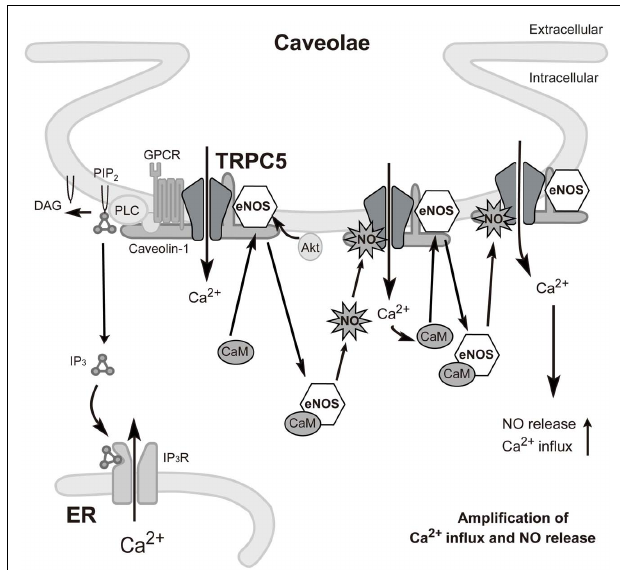
FIGURE 3 | Proposed model forTRPC5-mediated feedback cycle of receptor-activated Ca 2 + and NO signaling in caveolae of endothelial cells. Stimulation of GPCRs (such as the ATP-activated P2Y receptor) induces Ca 2 + influx and activation of eNOS as a consequence of binding of Ca 2 + –CaM and release of eNOS from caveolin-1.TRPC5 undergoes eNOS-dependent S-nitrosylation after GPCR stimulation, resulting in amplified Ca 2 + entry and secondary activation of eNOS to amplify production of NO. GPCR: G protein-coupled